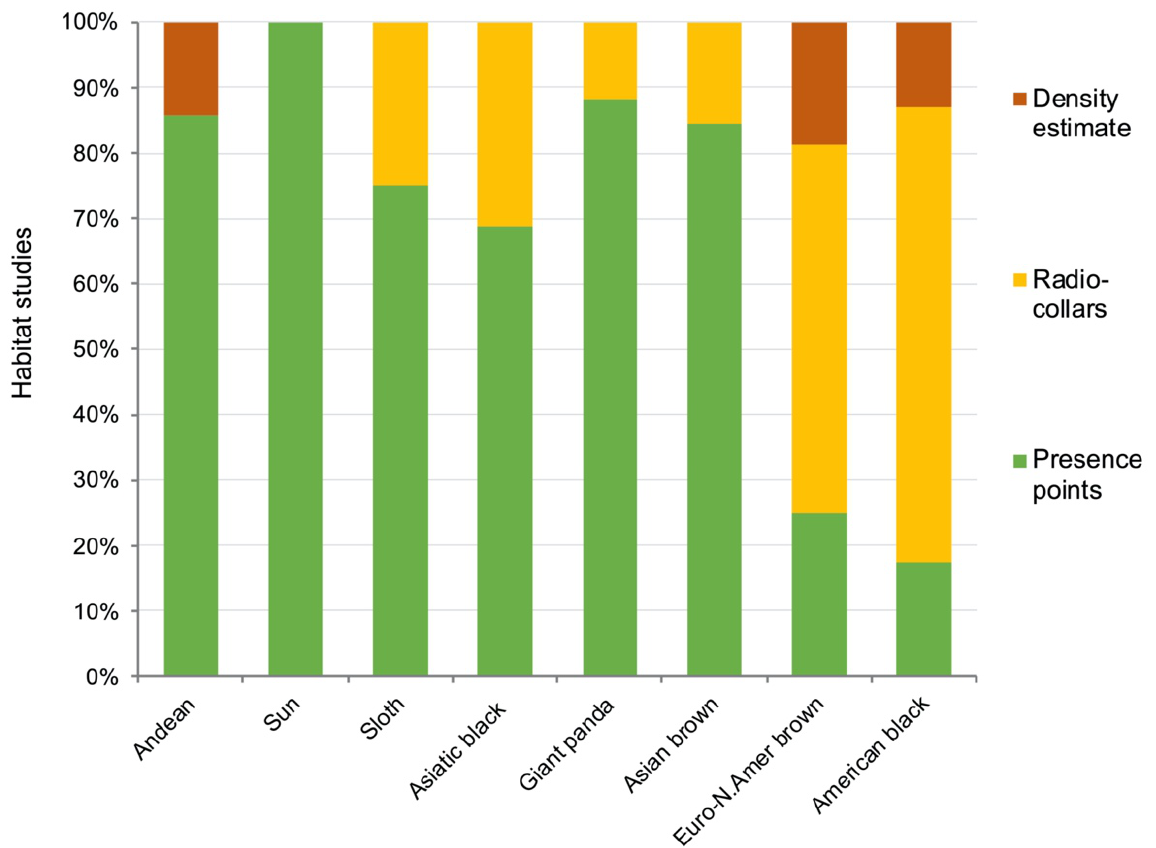
Figure 2. Relative use of presence points, locations of radio-collared bears, and site-specific density estimates in studies of habitat use, selection, and suitability for the seven species of terrestrial bears. Brown bears are split because of continental differences in the use of these methods. Use of density for Andean bears may be exaggerated by small sample size ( n = 7 total studies). Data are from published papers, mainly since 2000, cited in text ( n = 141), which may not be a perfect representation of all studies.